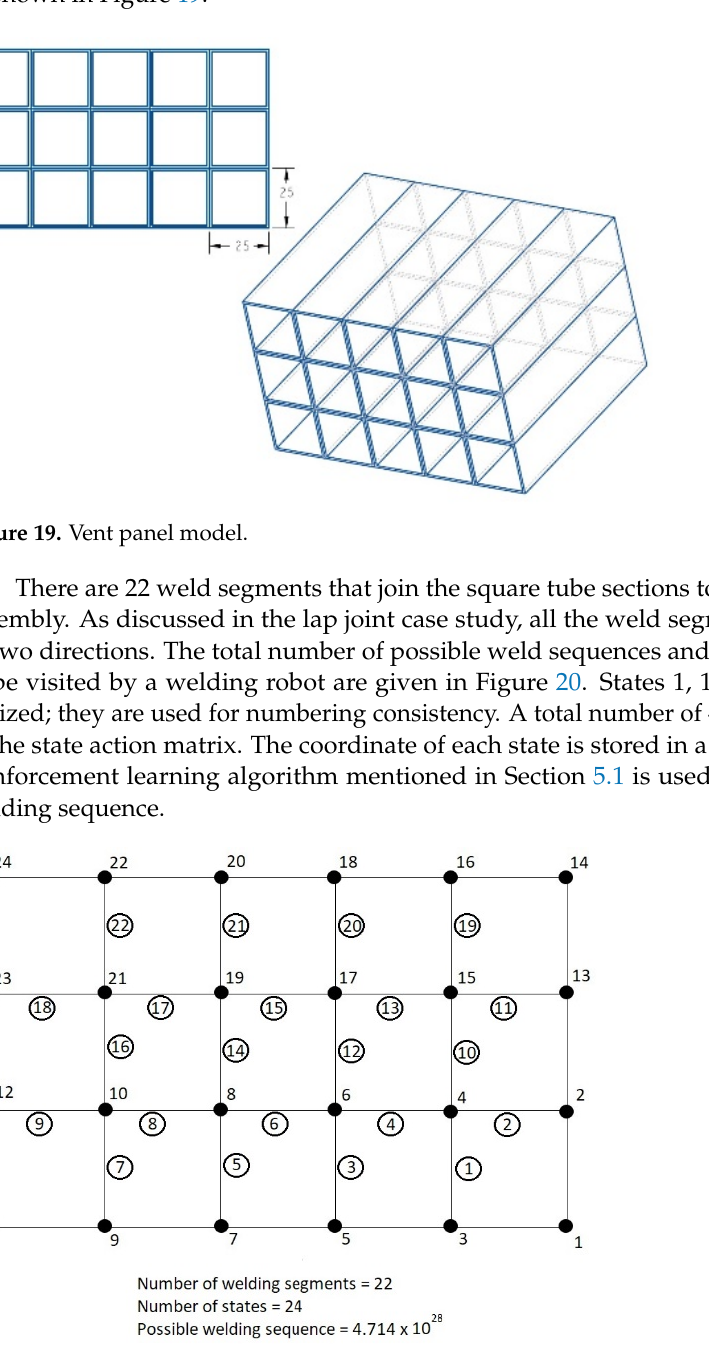
Figure 20. State action diagram for vent panel.